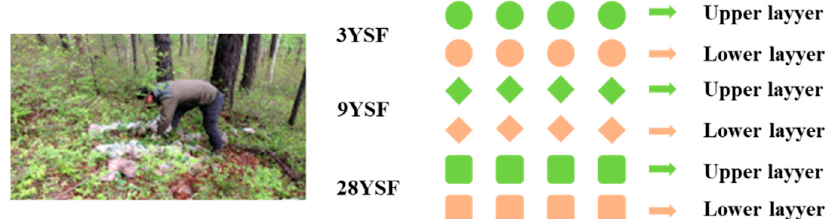
Figure 2. Map of the experimental design. Note: Green: the litter arranged on the upper layer; Orange: the litter arranged on the lower layer. The shape of the litter decomposition bag used was the same for each sample taken at sites representing the same number of years since the fire occurred, indicating that the litter was homogeneous at the beginning of the layout.